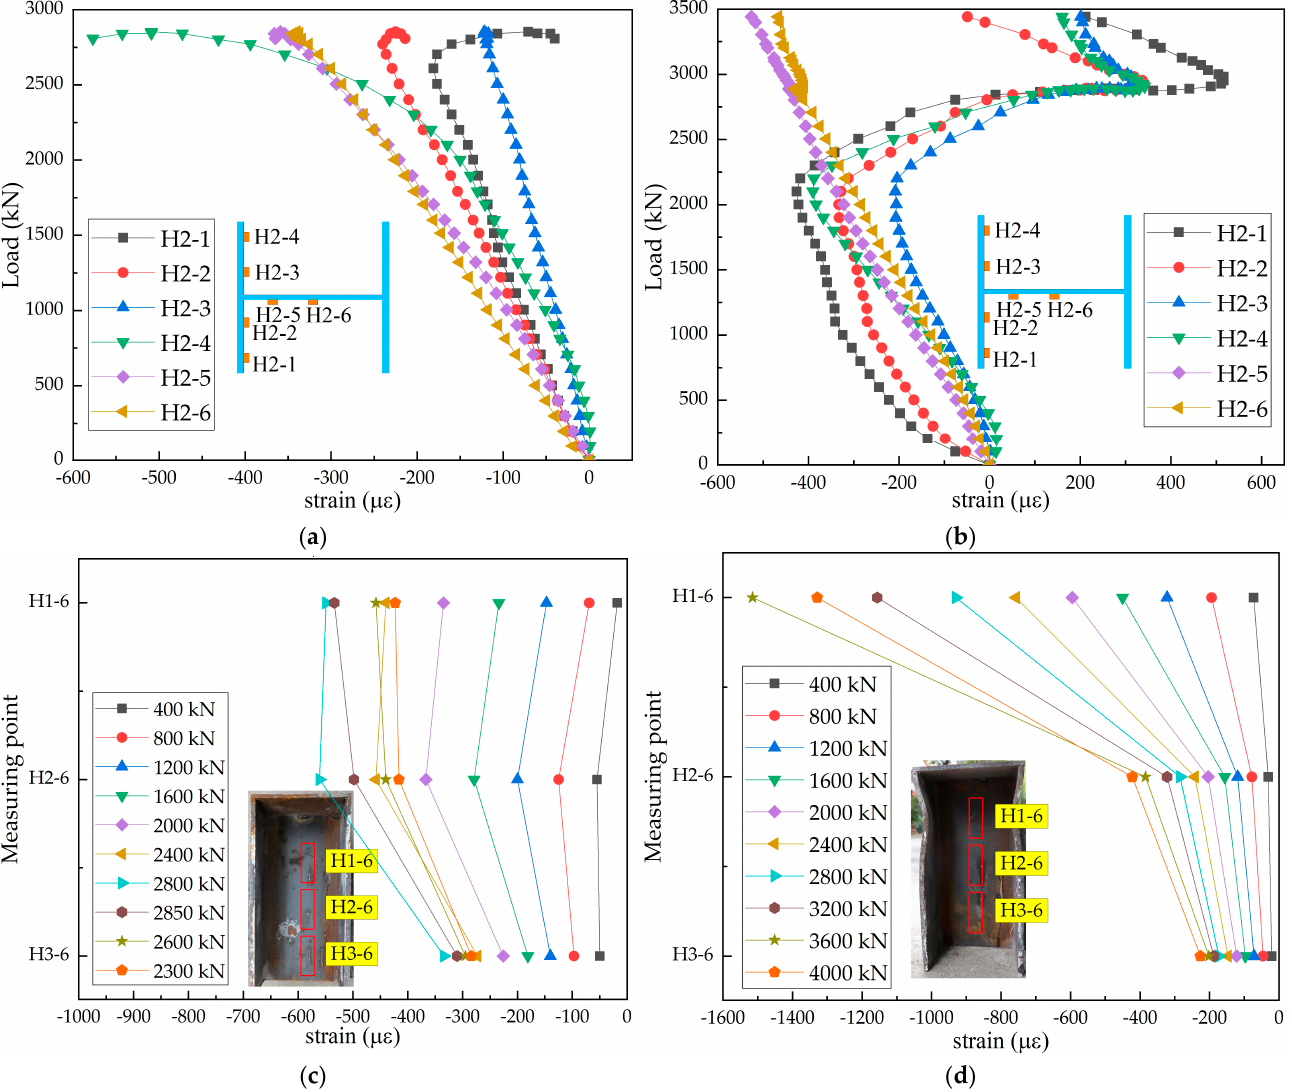
Figure 8. Load–strain curves of H-shaped steel beams: ( a ) N-20-3; ( b ) S-20-3; ( c ) N-20-3; and ( d ) S-20-3.